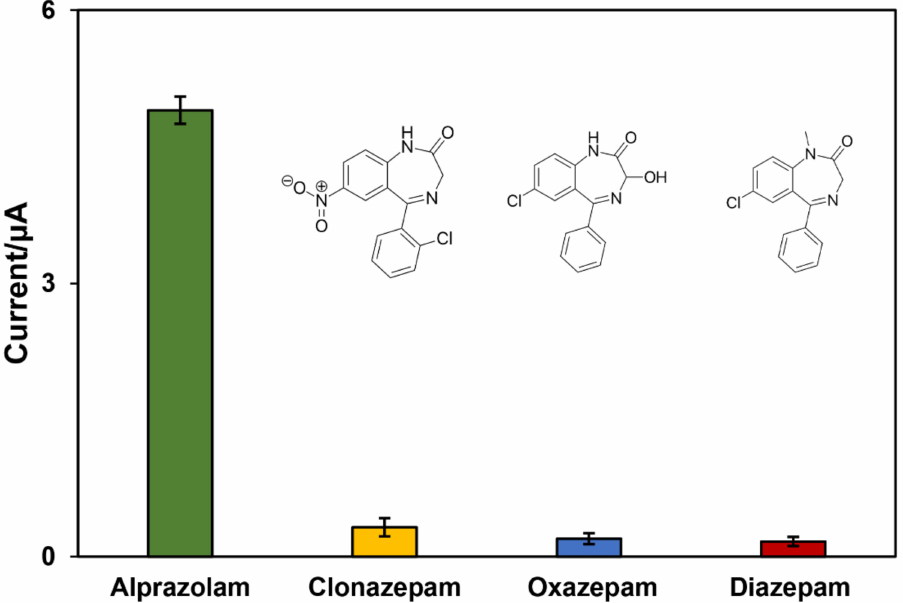
Figure 8. Selectivity of the fabricated nanobiosensor in alprazolam detection in comparison to similar drugs: clonazepam, oxazepam, and diazepam (n = 5).